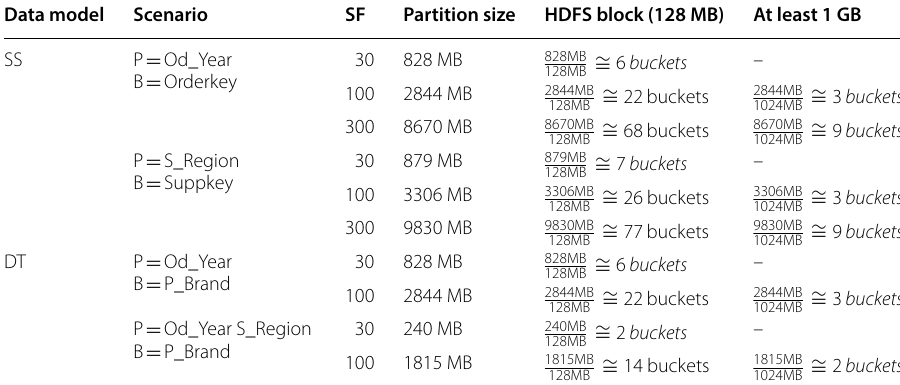
Italic values highlight the approach used for the definition of the number of buckets